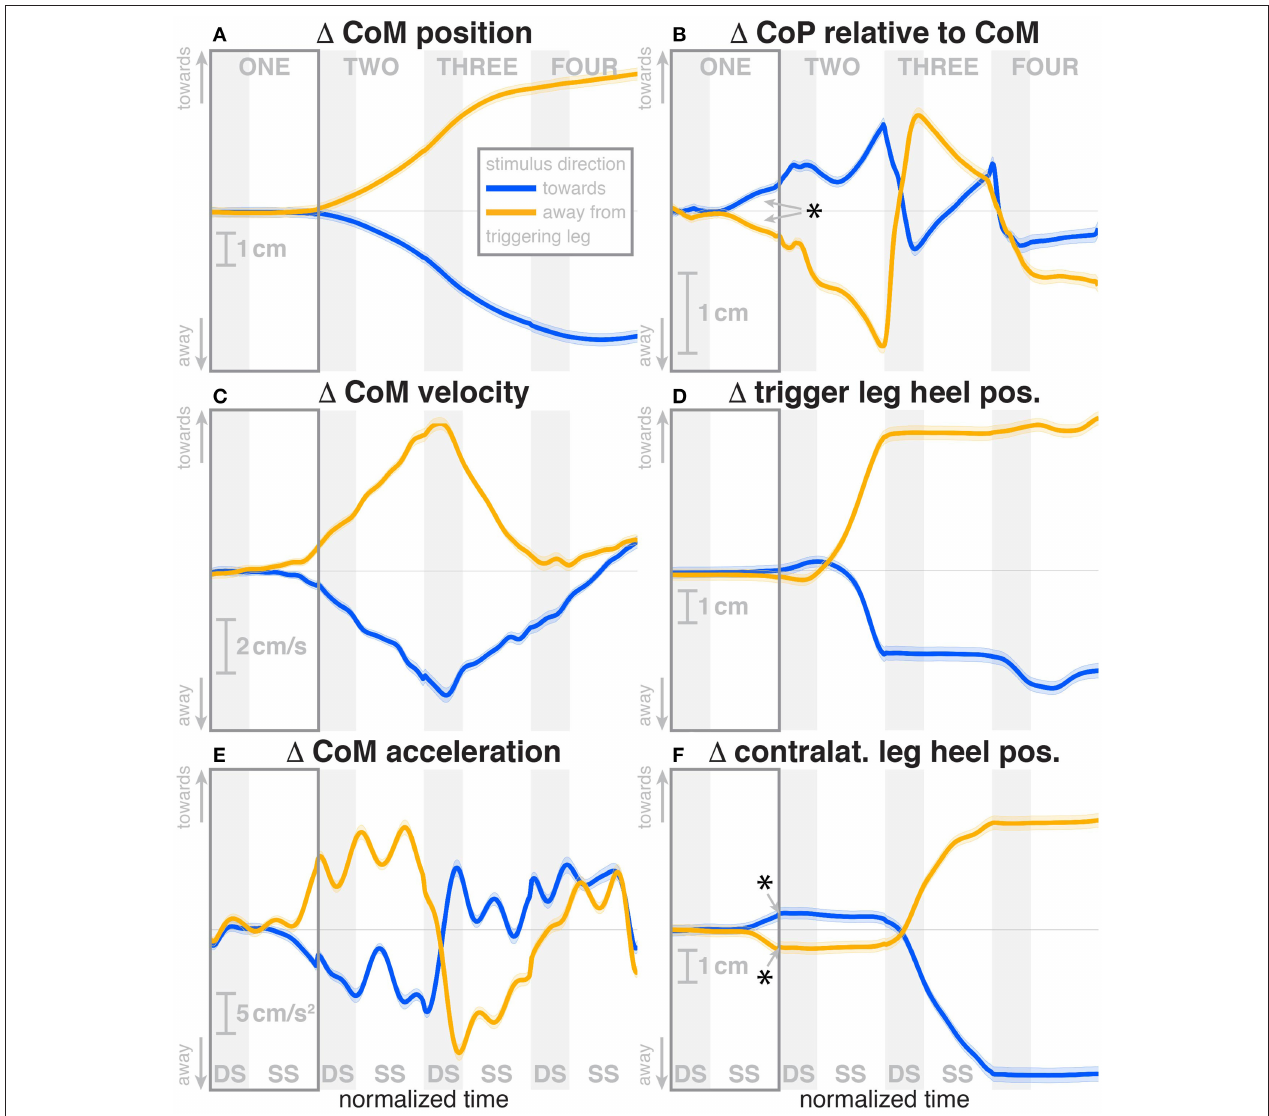
FIGURE 2 | Changes in response to the visual stimulus in the medial-lateral CoM kinematics (A,C,E) , CoP (B) , and heel positions (D,F) . The baseline represents the average of the control steps. Curves start at the heelstrike triggering the stimulus and show the subsequent four steps in normalized time, with the first step marked for clarity. Blue curves correspond to fall stimuli toward the triggering leg, orange curves to fall stimuli away from the triggering leg. Asterisks indicate statistically significant difference from zero (see Table 3 ). Lack of marks indicate that no hypothesis was statistically